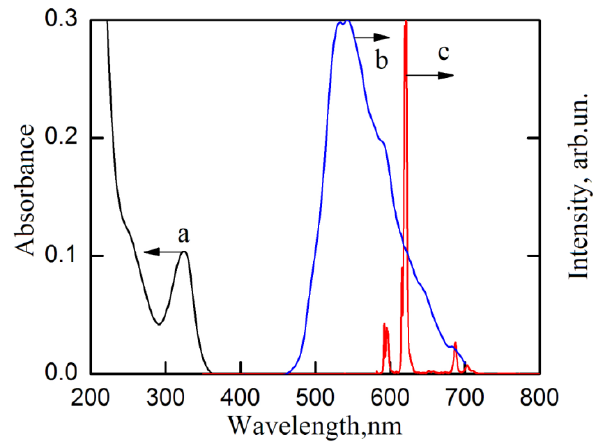
Figure 4. Absorbance spectra of europium complex acetonitrile solution, concentration C = 1·10 −5 mol/L ( a ); phosphorescence emission spectrum of gadolinium complex in solid state at 77 K, λ ex = 395 nm ( b ); luminescence emission spectrum of europium complex in solid state at 77 K, λ ex = 320 nm ( c ).